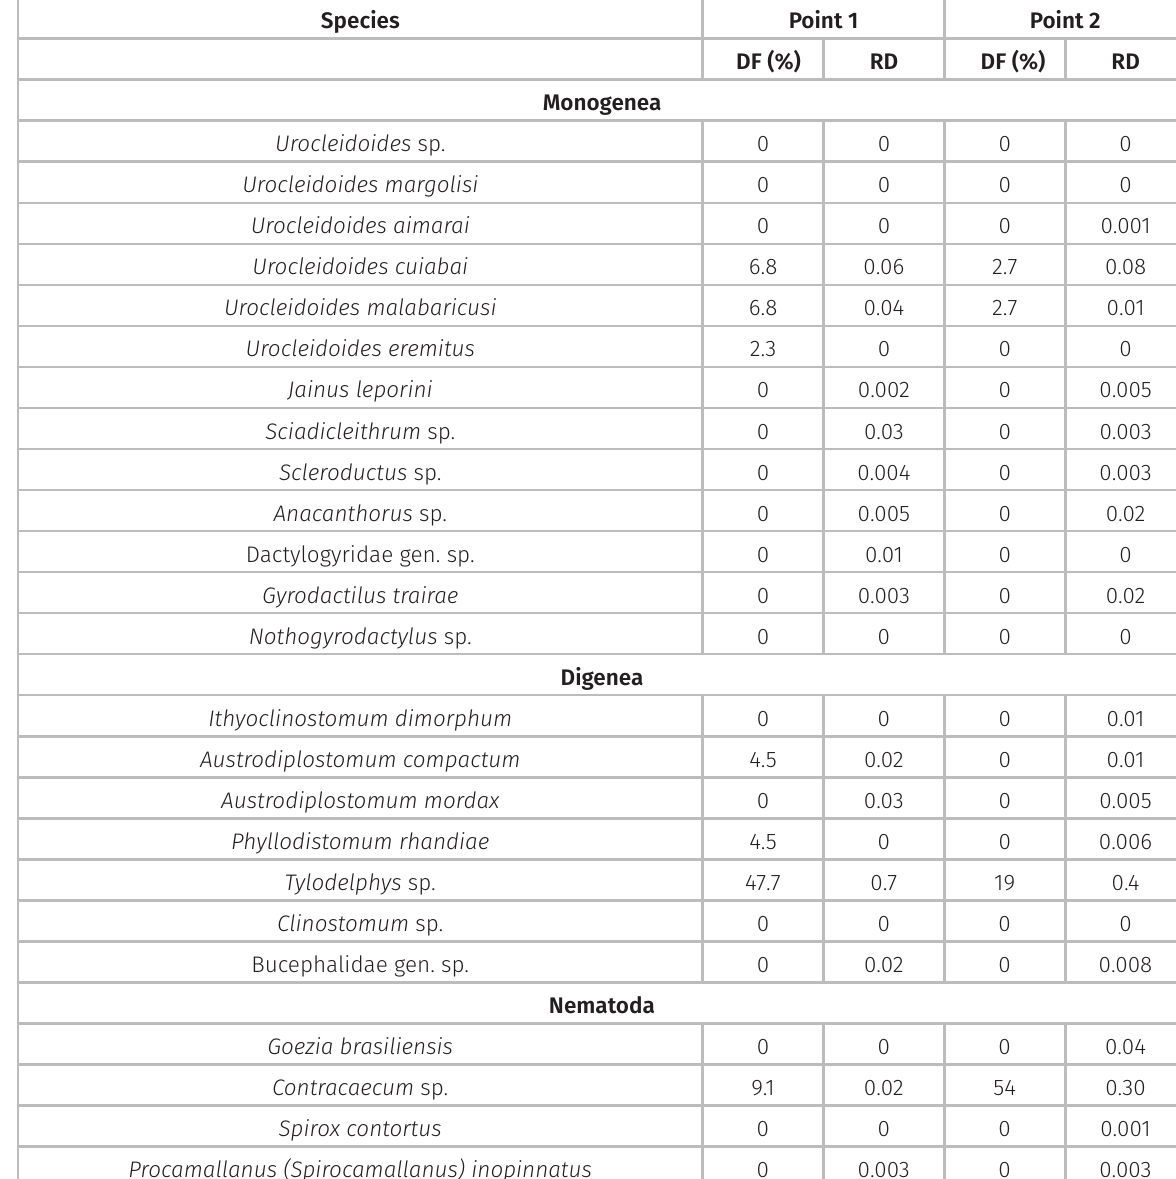
Table III. Dominance indexes for each component of Hoplias malabaricus (Bloch, 1794) parasitic component community collected at two points on the Batalha River in São Paulo State, Brazil, between February 2014 and June